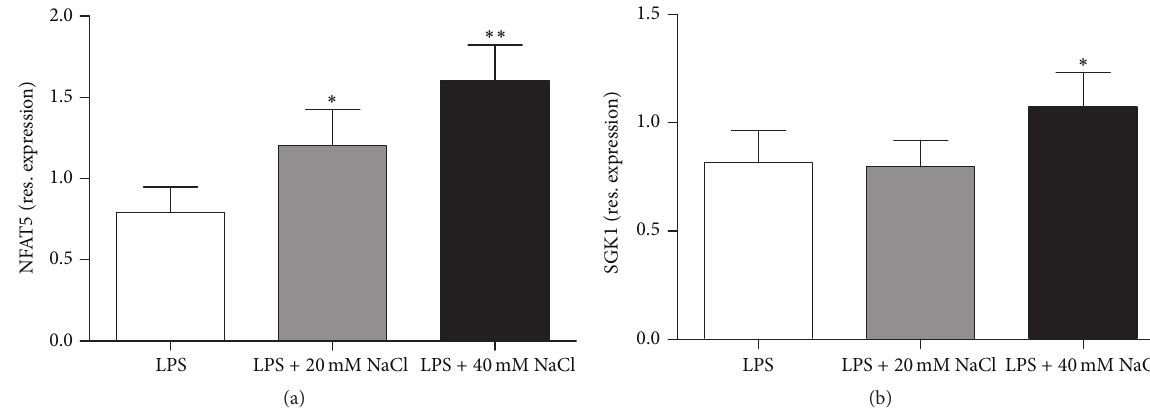
Figure 5: NaCl promoted the expression of NFAT5 and SGK1 on mRNA level in ARPE-19 cells. Cells were stimulated by LPS and incubated with medium alone or additional different concentrations (20 mM or 40mM) of NaCl for 3h following preculturing in serum-free medium. Then RNA was isolated and the expression of NFAT5 (a) and SGK1 (b) was measured by RT-PCR. ∗ 𝑃 < 0.05 and ∗∗ 𝑃 < 0.01 compared to the control. All results are analyzed following three separate experiments, 𝑛 = 7 . Paired-samples t -test (when the difference between the two tested groups conforms to normal distribution) or Wilcoxon matched-pairs test (when the difference between the two tested groups does not conform to normal distribution) was used for statistical analyses for LPS control versus LPS + 20 mM NaCl or LPS + 40 mM NaCl in each